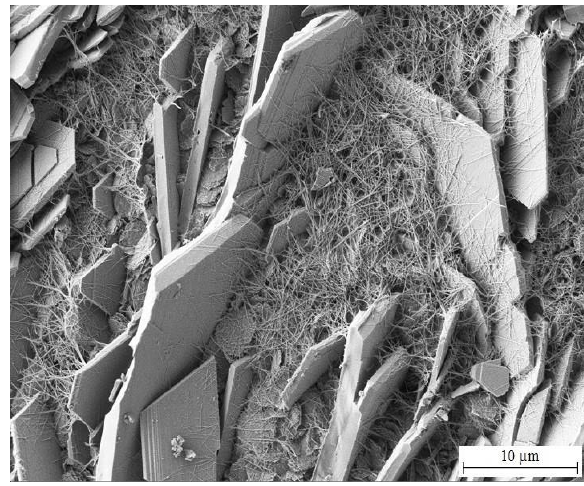
Figure 19. SEM—distribution of Zn/Ca/Mn/O on cross section in precipitate of corrosion products (exposure in simulated concrete pore solution of pH 12.8 with addition of KMnO 4 (Mn (1) )).